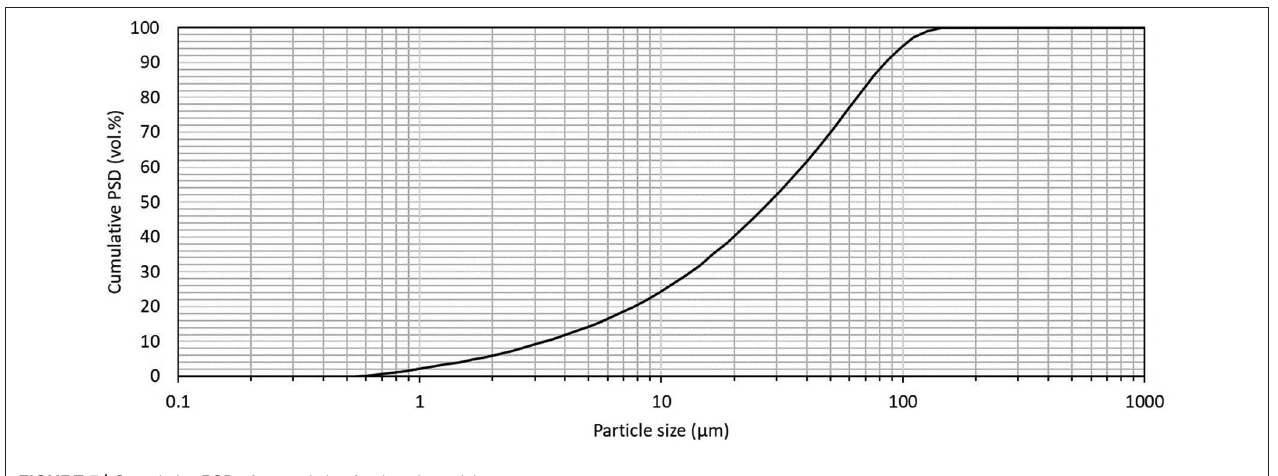
FIGURE 7 | Cumulative PSD of ground slag feedstock particles.